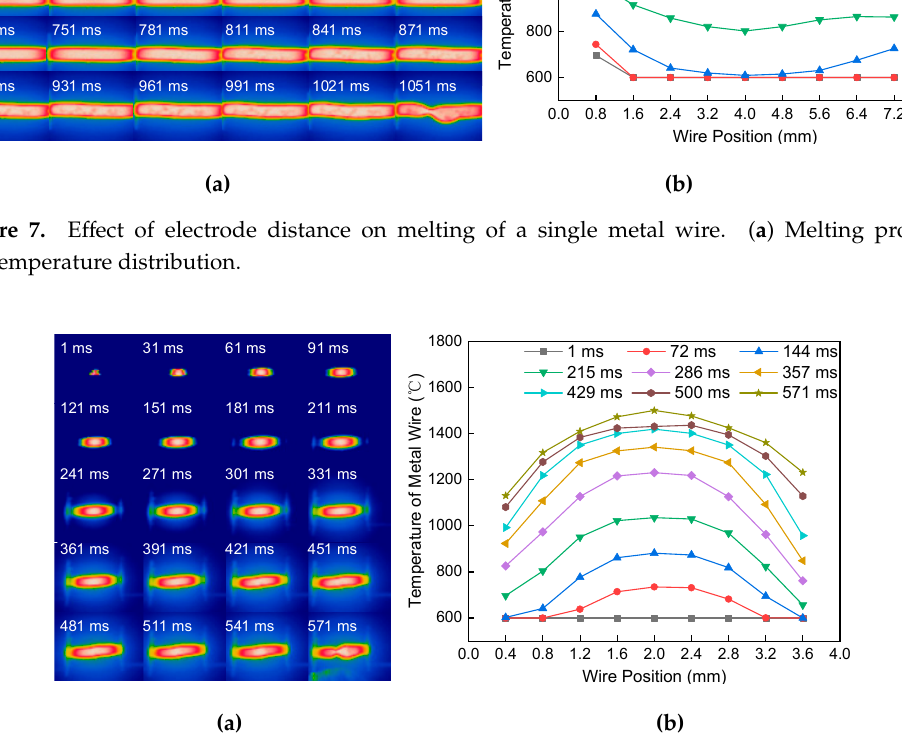
Figure 8. E ff ect of wire diameter on the melting of single metal wire. ( a ) Melting process. Figure 8. Effect of wire diameter on the melting of single metal wire. (a) Melting process. (b) ( b ) Temperature Temperature distribution.